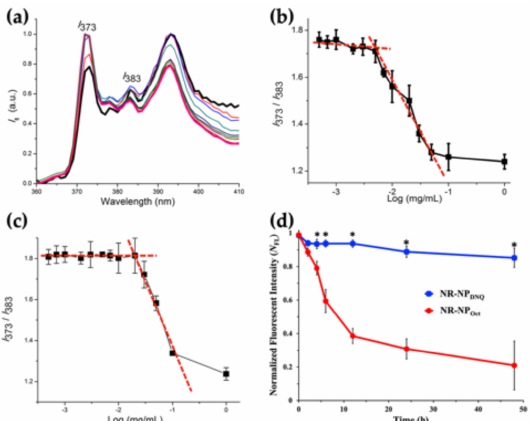
Figure 3. ( a ) Normalized emission spectra of pyrene in solutions of PEG-PLL-DNQ in PBS; emission intensity of pyrene at 373 and 383 nm versus the concentrations of ( b ) PEG-PLL-DNQ and ( c ) PEG- PLL-Oct; ( d ) stability of NR-NP DNQ (d-blue) and NR-NP Oct (d-red) in BSA solution. Data are means ± SD, N = 4, asterisks indicate p <